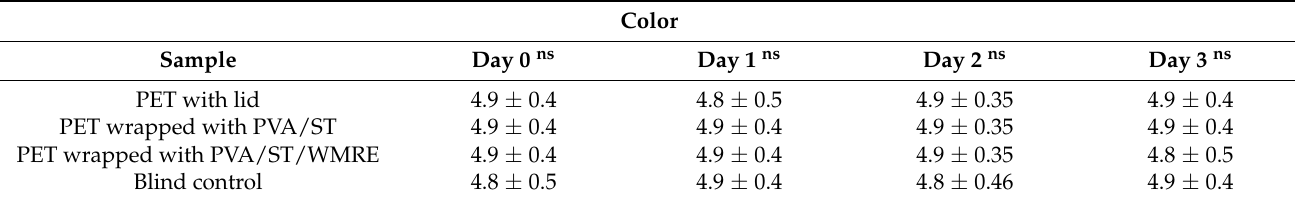
Table 3. The quality assessment on color of fresh-cut purple cabbage. Color